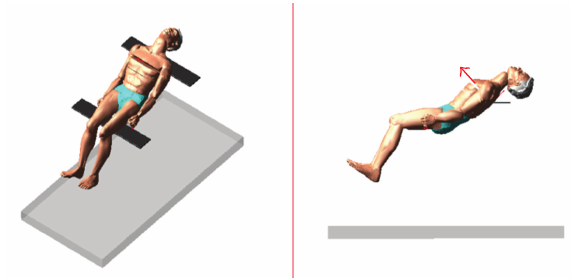
Figure 7: The simulation